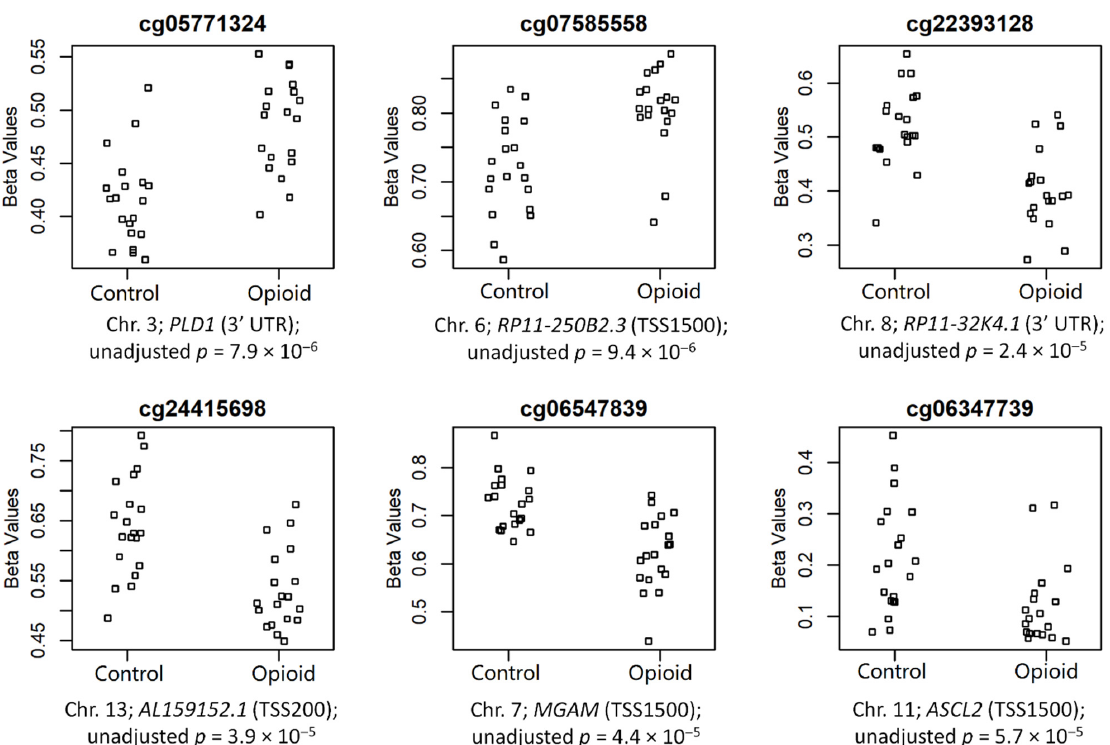
Figure 4. Normalized beta values are shown by groups (controls vs. opioid-exposed) for the top 6 annotated CpG sites associated with opioid exposure. CpG site names are above each plot, and chromosome numbers, associated genes, genomic regions, and unadjusted p -value are below each plot.